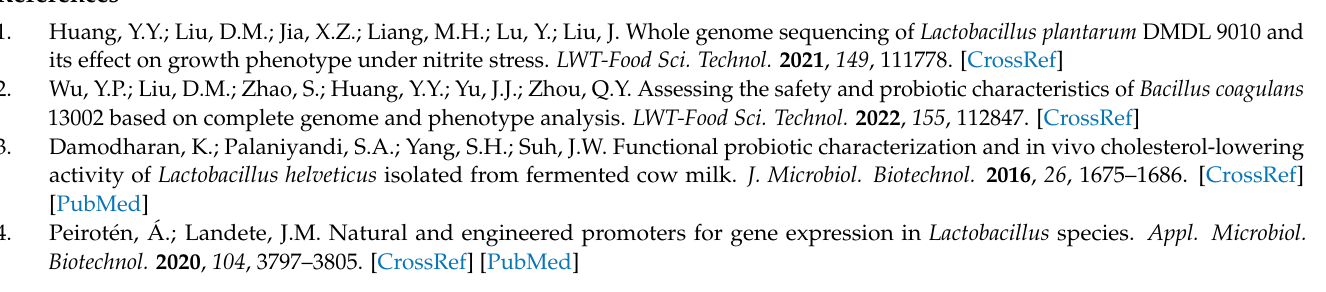
genes detected in L. rhamnosus